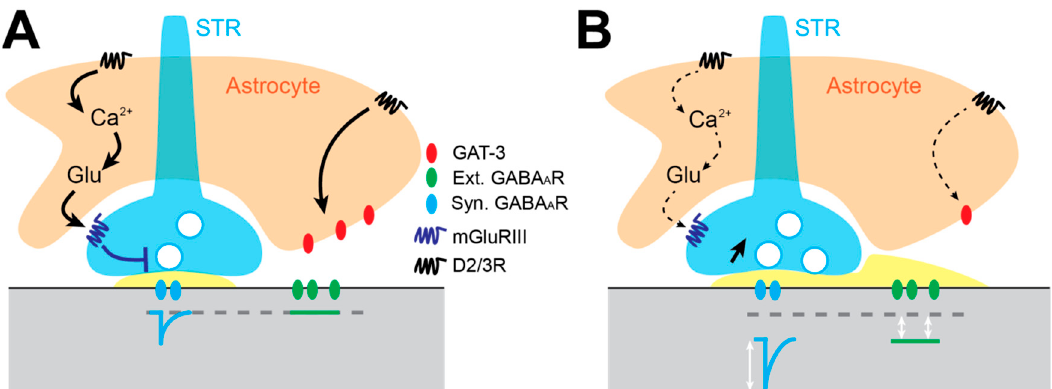
Figure 2. Mechanisms underlying GABAergic synaptic alterations in the GP in experimental PD. ( A ) In DA-intact conditions, D2 receptors present on astrocyte membranes elevate intracellular calcium levels and promote glutamate gliotransmission. Glutamate activates group III mGluR (GluRIII), which reduces GABA release probability at striato-pallidal synapses. D2Rs also regulate GAT-3 activity by an unknown mechanism, preventing GABA spillover from GABAergic synapses and hence activation of extrasynaptic GABA A receptors. ( B ) Under DA-depleted conditions, D2Rs are no longer activated, glutamate gliotransmission is reduced and mGluRIII-dependent reduction of GABA release is lost, leading to an increase in striato-pallidal transmission. The loss of D2R modulation of GAT-3 triggers a downregulation of the expression of the transporters, and the elevation of extracellular GABA concentrations leads to the activation of extrasynaptic GABA A receptors, which favors tonic inhibition.